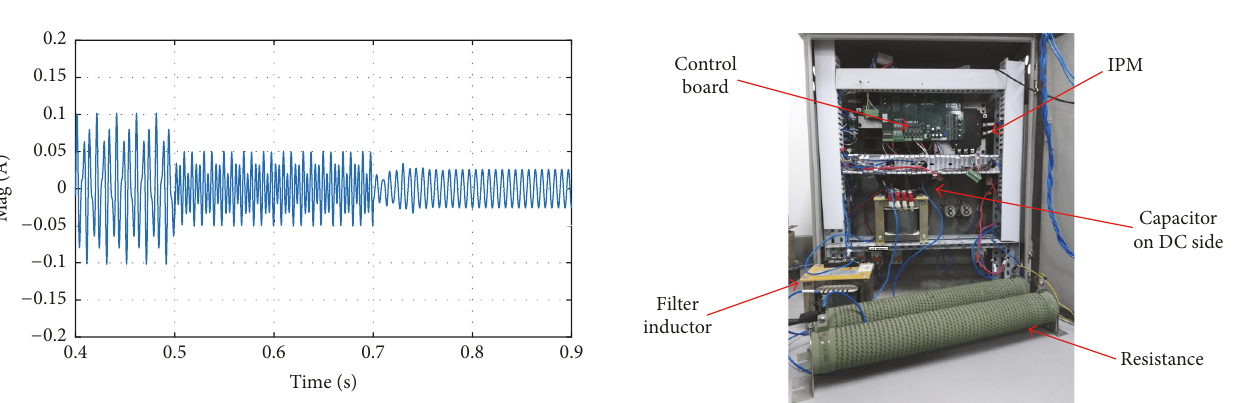
Figure 7: Experimental setup of single-phase voltage source con-